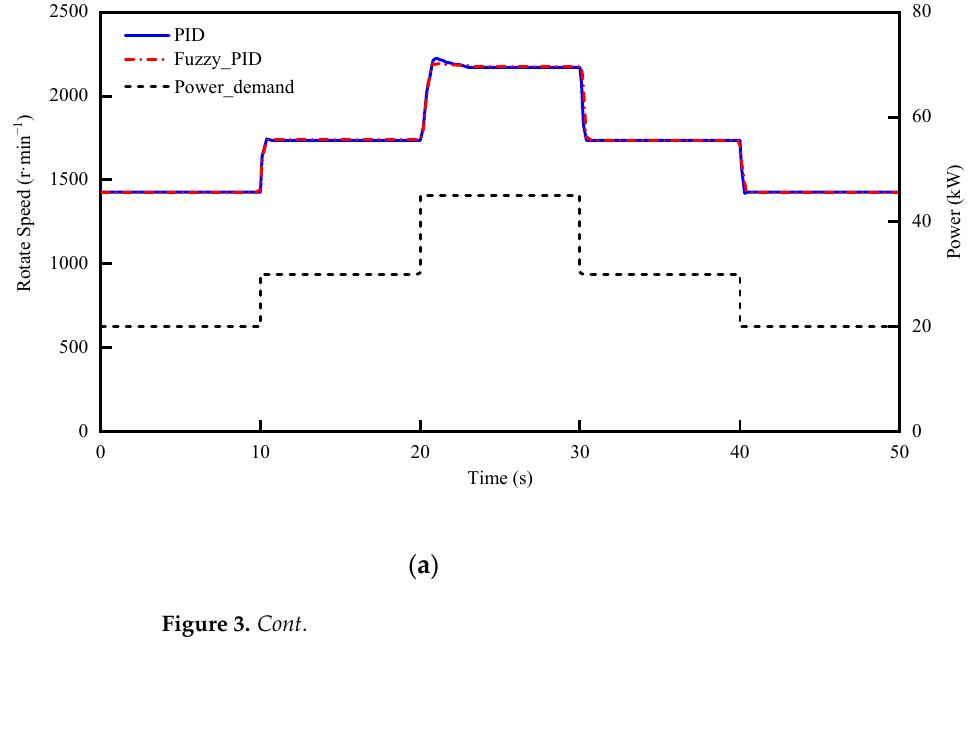
Table 4. Main test conditions.